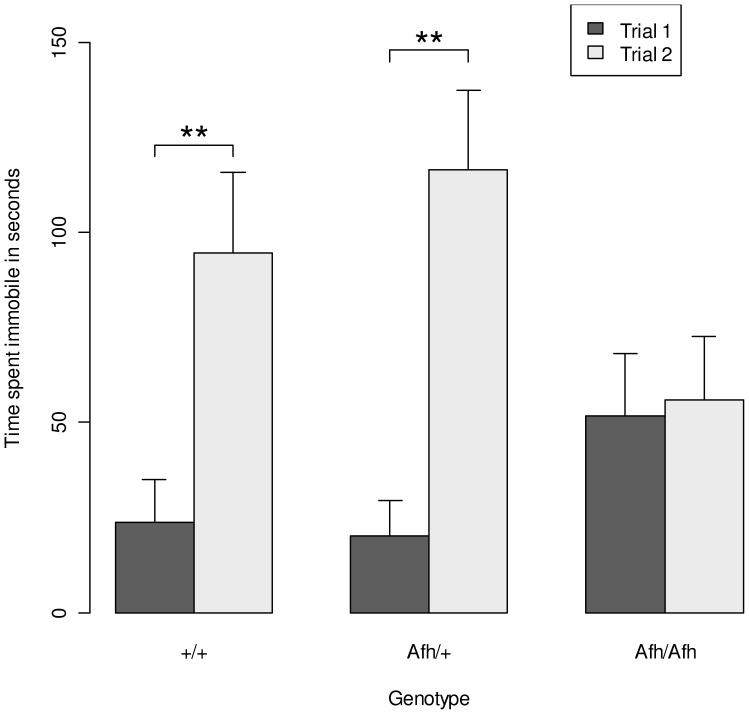
Immobility in the forced swim test is attenuated in after hours mice.Results from the forced swim test indicate no significant difference in immobility in trial 1 but the increase in immobility observed in trial 2 was not seen in Afh/Afh mice. (Data shown is mean ± SEM). **, P<0.01 results from posthoc t-tests comparing immobility in trial 1 vs. trial 2 in Afh/Afh. Afh/+ and +/+ mice.